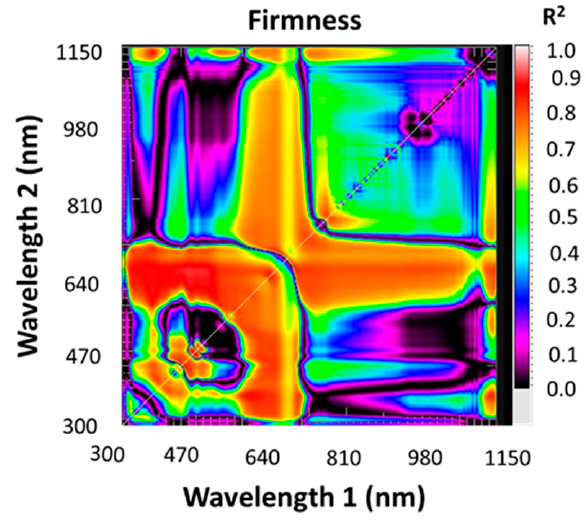
Figure 1. Correlation matrices displaying (R 2 ) values for possible dull wavelength together ranging from 302 to 1148 nm with Chl a, Chl b, respiration rate, TSS, and firmness of banana fruits.